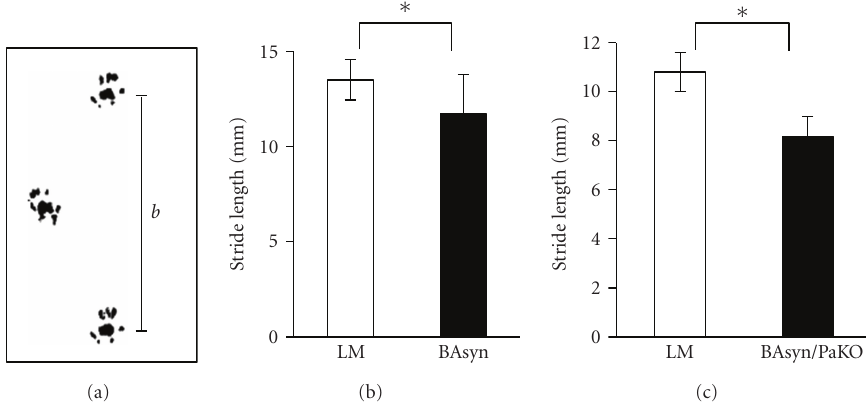
Figure 4: Footprint analyzes of BAsyn and BAsyn/PaKO. Footprints (a) and stride length ((b), (c)). The stride lengths of 8–10 mice per group were determined, error bars = SD, U -test, ∗ P < .